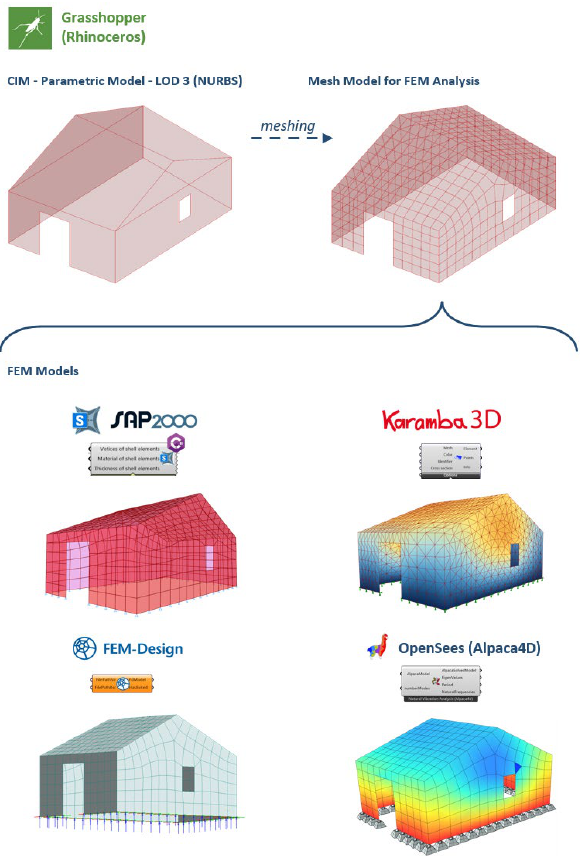
Figure 6 . Parametric CIM model discretized into FEM